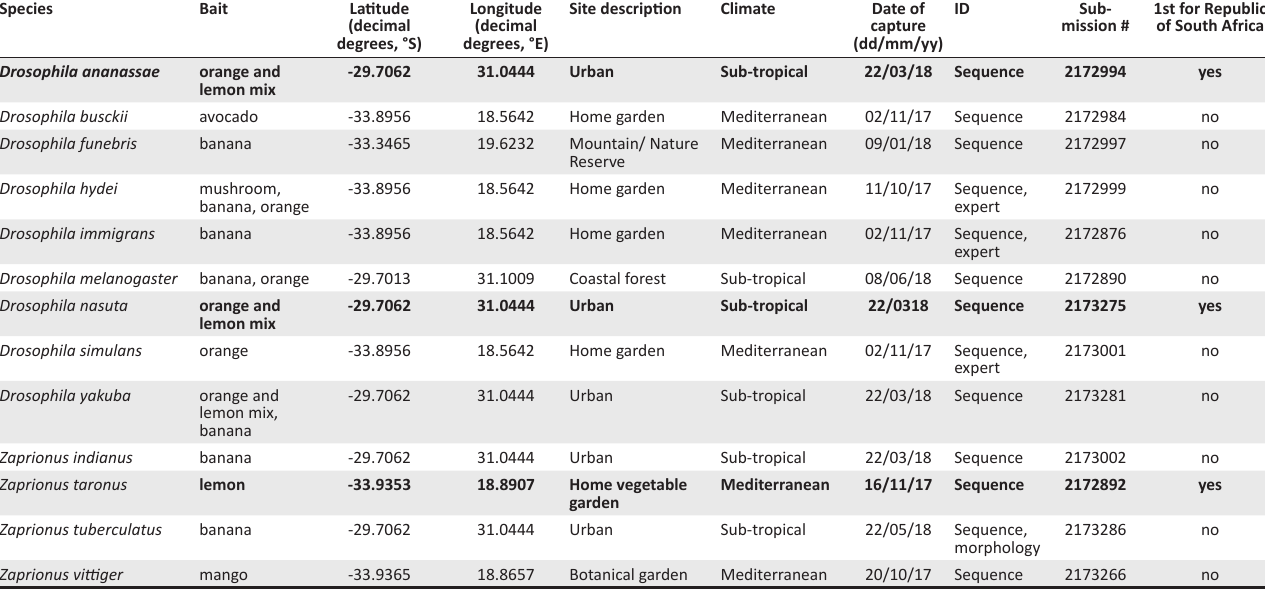
TABLE 1: The locations and description of collection sites, date of capture, method of identification (ID; by COI barcode [Sequence], by Drosophila expert [expert], identified by author using morphological keys [morphology]), bait type and National Center for Biotechnology Information (NCBI) accession numbers for the 13 Drosophilidae species collected in our study in South